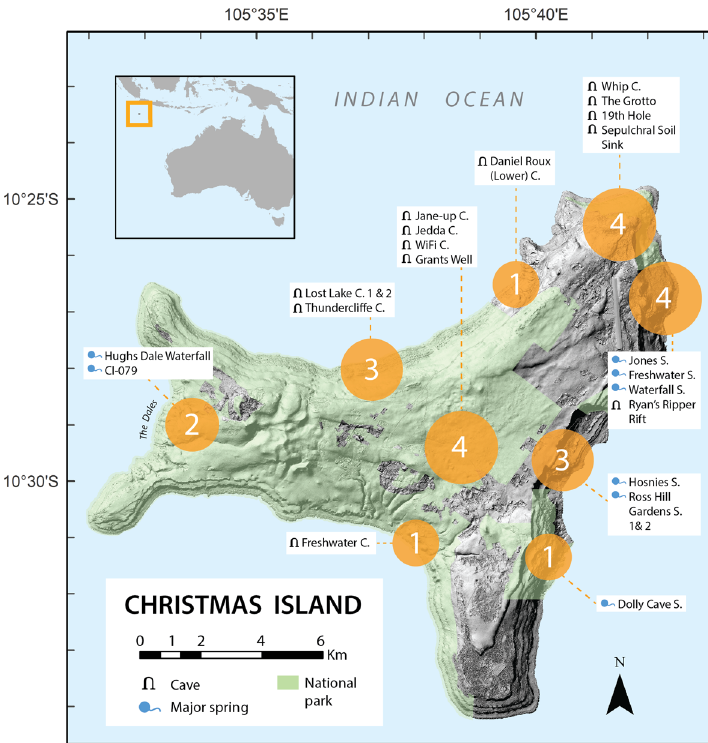
Figure 1. Location of eDNA sampling sites on Christmas Island. Orange spheres give the approximate number and location of sampling sites; topographical symbols indicate whether samples from each respective site were taken from within a cave system or at a surface spring. Hillshade relief and national park boundary data was sourced from Geoscience Australia 53 . Map was produced in ArcGIS Desktop 10.6 54